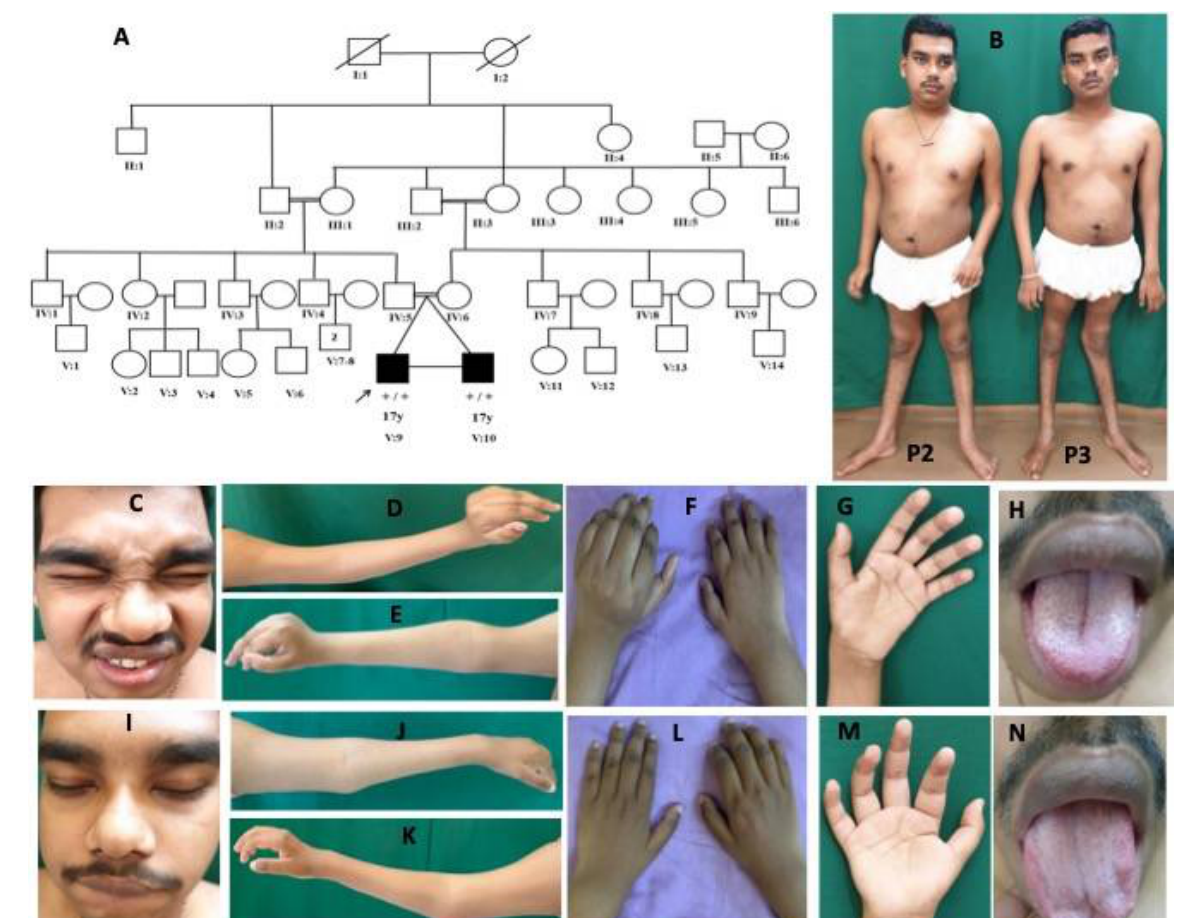
Figure 3. Pedigree and clinical images of patients 2 and 3 with DA5D: ( A ) pedigree of family 2; ( B ) clinical photograph of patients 2 and 3 showing contractures at elbows, fingers, hyperlordosis, and hyperextension at the knee; ( C – H ) patient 2: ( C ) facial weakness, hypertelorism, bulbous nose; ( D – G ) Left > Right contracture at elbows, wrist in extension and fingers at metacarpophalangeal (MCP) and interphalangeal joint (IPJ), and ( H ) furrowed tongue; ( I – N ) patient 3: ( I ) facial weakness, hypertelorism, bulbous nose; ( J – M ) Right > Left contracture at elbows, wrist in extension, and fingers at MCP and IPJ, and ( N ) atrophy of tongue.